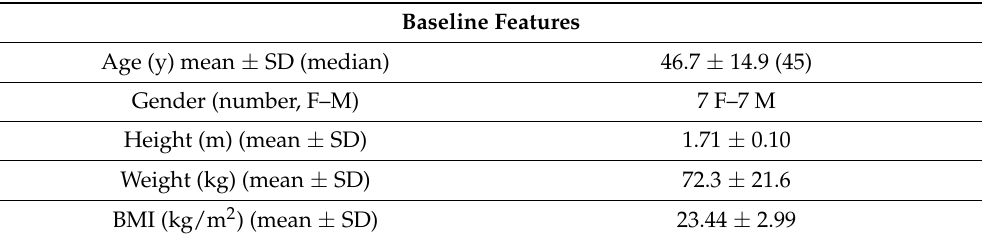
Table 1. Mean and Standard Deviation for baseline features of healthy subjects. Standard